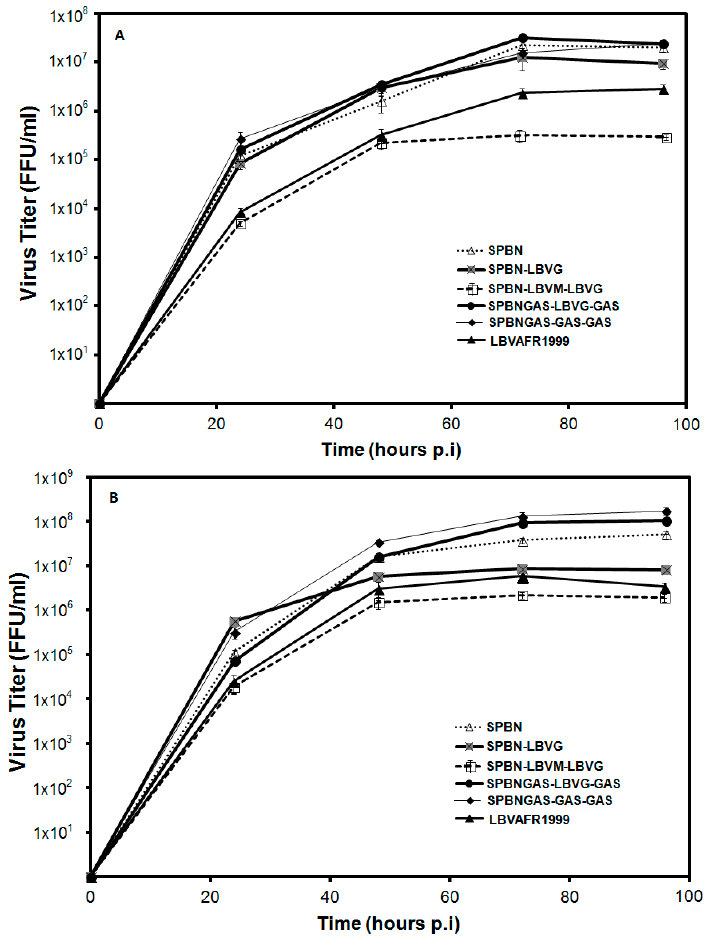
* 10 3 FFU of each challenge virus was used; # VNI = virus titer of untreated challenge virus – virus titer of challenge virus incubated with anti-LBV serum.